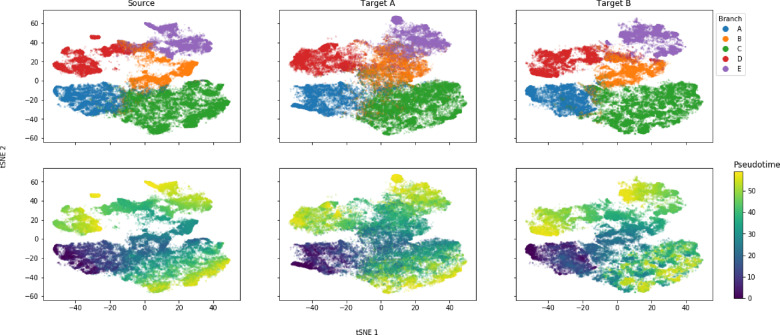
Integrated latent space of three synthetic datasets. Three single-cell ’omics datasets (Source, Target A and Target B) are generated (Papadopoulos et al., 2019) from a shared underlying temporal branching process (as defined in Fig. 3). The same branching process was used in all three cases, but the parameters governing their feature distributions are drawn with different seeds. Hence, their latent structure is the same, yet they share no correspondences between features. SCIM is run, fully supervised using the branch label, and all datasets are embedded into a shared latent space. tSNE embeddings (Maaten and Hinton, 2008) are computed and visualized on the combined latent representations from all three datasets. Each column shows only the cells from a single technology. In the top row cells are colored by their branch label, as indicated on the legend. In the bottom row, the cells are colored by their pseudotime, as indicated on the color bar on the right-hand side